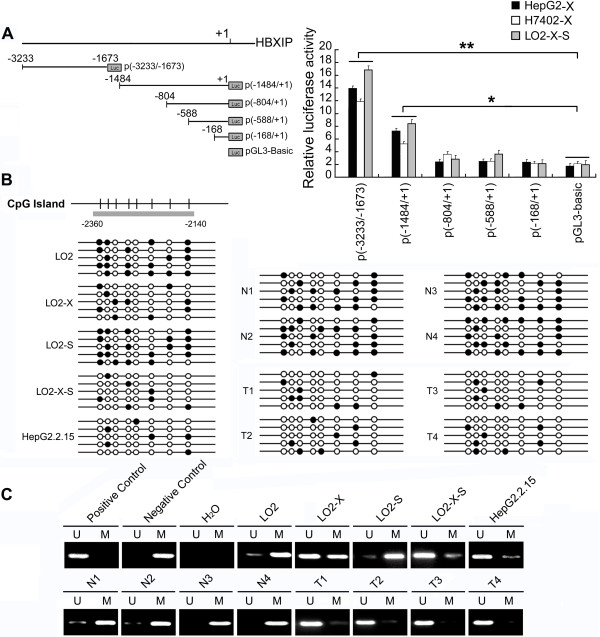
HBx survivin-dependently up-regulates HBXIP via DNA demethylation of HBXIP. (A) Schematic representation of the HBXIP promoter was shown. The activities of different fragments from HBXIP promoter were tested by luciferase reporter gene assays in HepG2-X, H7402-X and LO2-X-S cells (*P < 0.05, **P < 0.01, Student’s t test). (B, C) The methylation levels of HBXIP CpG sites were examined by bisulfite sequencing and MSP analysis in the cells and clinical tissues (n = 4), respectively. Eight CpG sites were analyzed. Closed and open circle present methylated and unmethylated CpG site, respectively. N represents adjacent nontumorous tissue; T represents HCC tissue. Bands in the ‘M’ and ‘U’ lanes are PCR products obtained with methylation-specific and unmethylation-specific primers, respectively.